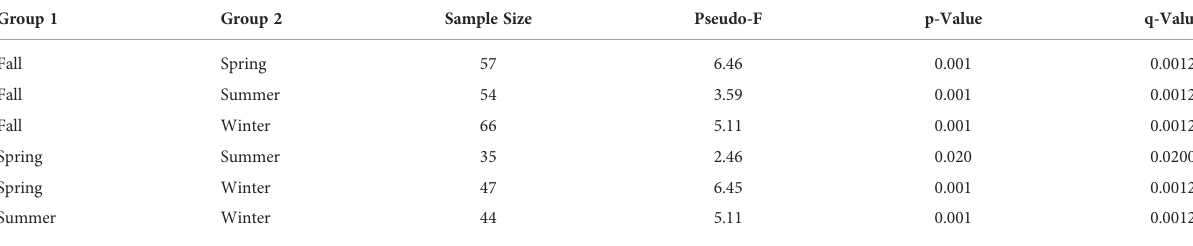
TABLE 2 Summary of pairwise PERMANOVA results for seasonality, based on Bray-Curtis dissimilarity and 101 samples.